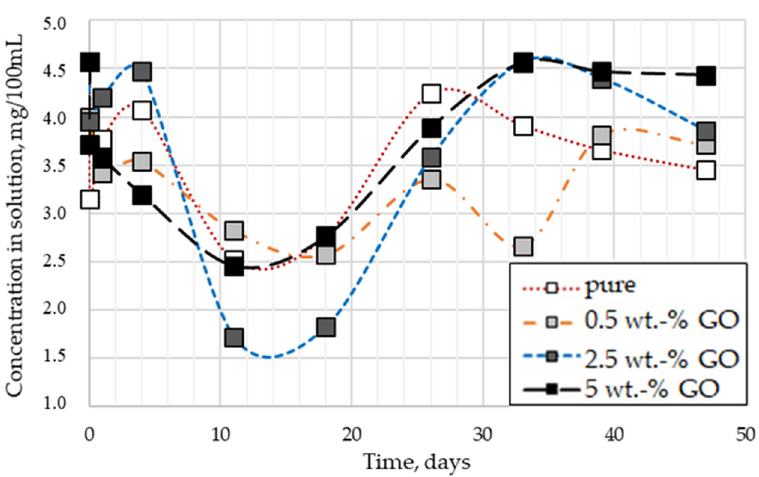
Figure 6. Sorption of IBU by pure Ultem membrane and containing different loadings of graphene oxide.